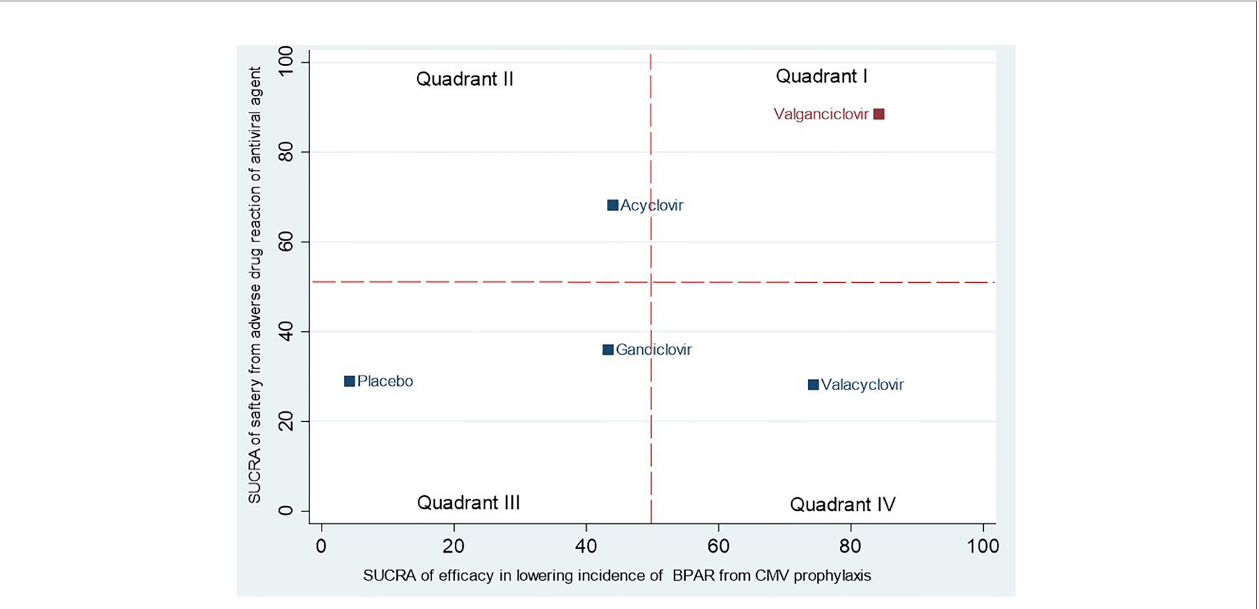
FIGURE 3 | Cluster ranking plot of antiviral agents showing their surface under the cumulative ranking curve (SUCRA) values for the highest probability of incidence of biopsy-proven acute rejection (BPAR) versus SUCRA values for the lowest probability of major adverse drug reactions (ADRs). Each square point represents a group of antiviral agents in each cluster. Antiviral agents lying in the upper-right corner are associated with a higher probability of incidence of BPAR and a lower probability of major